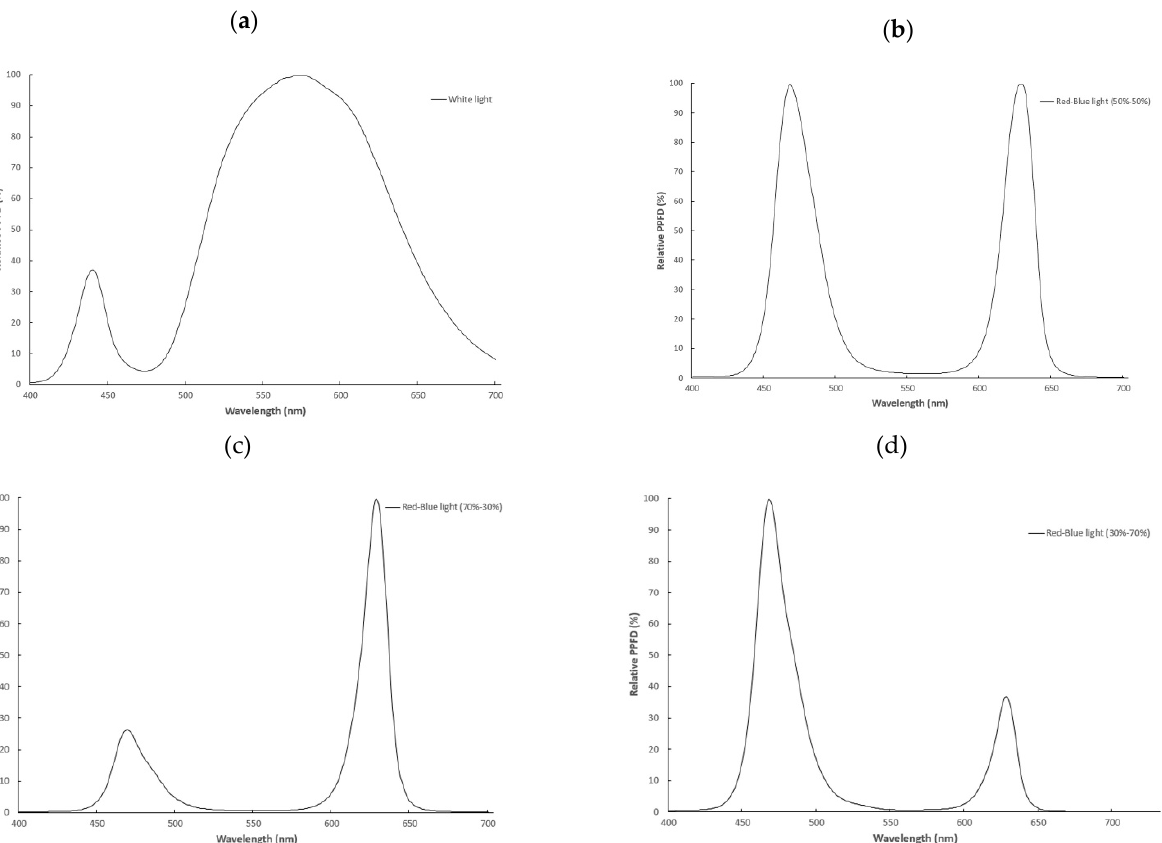
Figure 2. LED light treatments. ( a ) White. ( b ) Red − blue (50–50%). ( c ) Red − blue (70–30%). ( d ) Red-blue